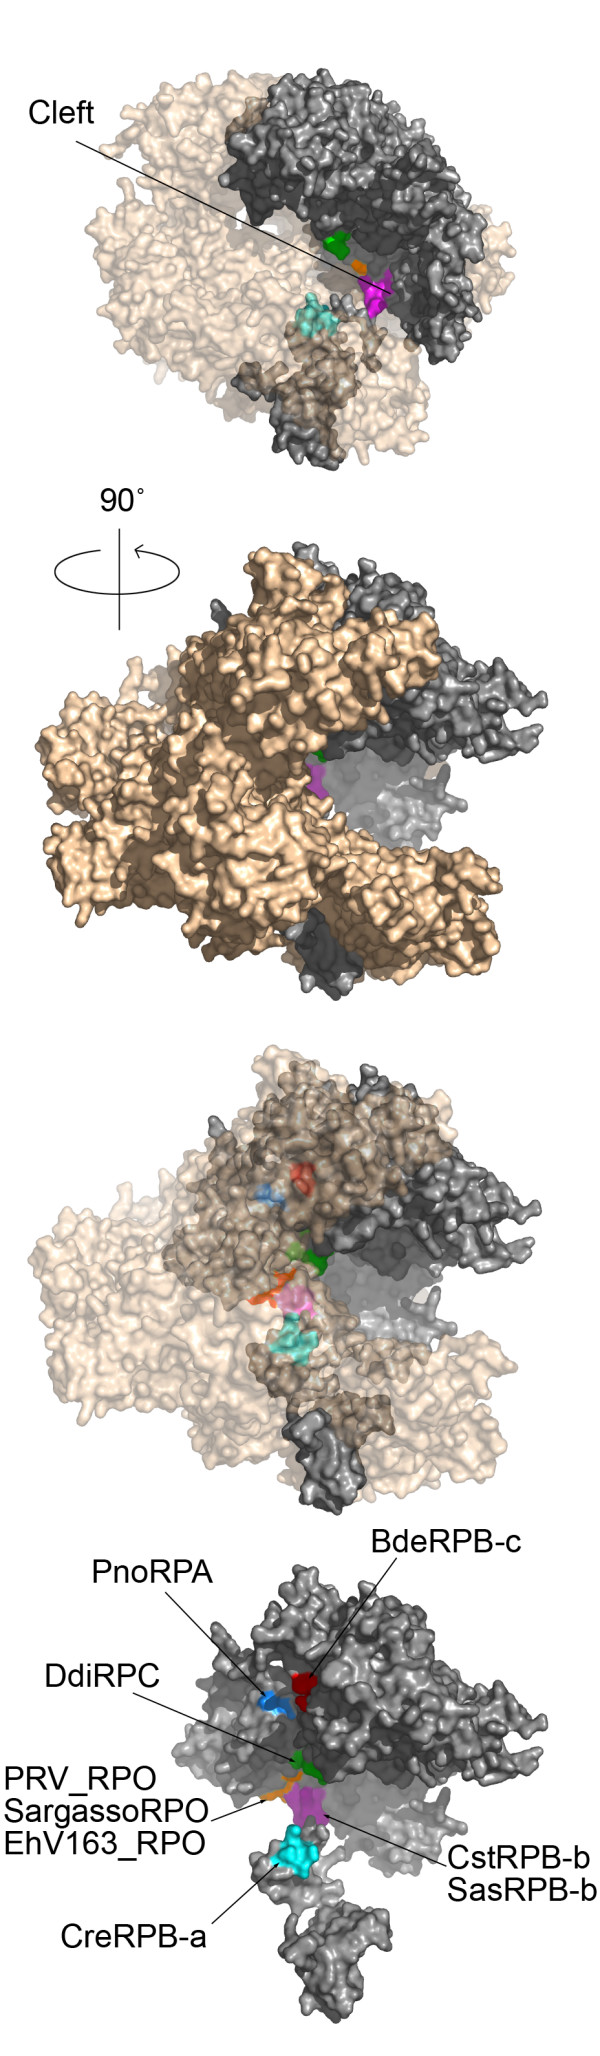
The position of the six RNA polymerase intein insertion sites mapped onto the crystal structure of the RNA polymerase II of Saccharomyces cerevisiae. Representation of S. cerevisiae RNA polymerase II (PDB: 1I3Q); the second largest subunit is coloured dark grey (other subunits, including the largest, are coloured light brown). Top: surface view showing the position of the cleft formed by the two largest subunits and the position of the four intein insertion sites (indicated by different colours) on the surface of the cleft, near the active site/"wall" region. Lower: three surface views from a different orientation; the middle image has all of the subunits other than the second largest subunit as a semi-transparent surface so that the position of the two intein insertion sites on the interface between RPB1 and RPB2 (red and blue regions) can be seen. The lowest image is of RPB2 only, but with the intein insertion sites labelled with the names of inteins inserted at these positions in some homologues.